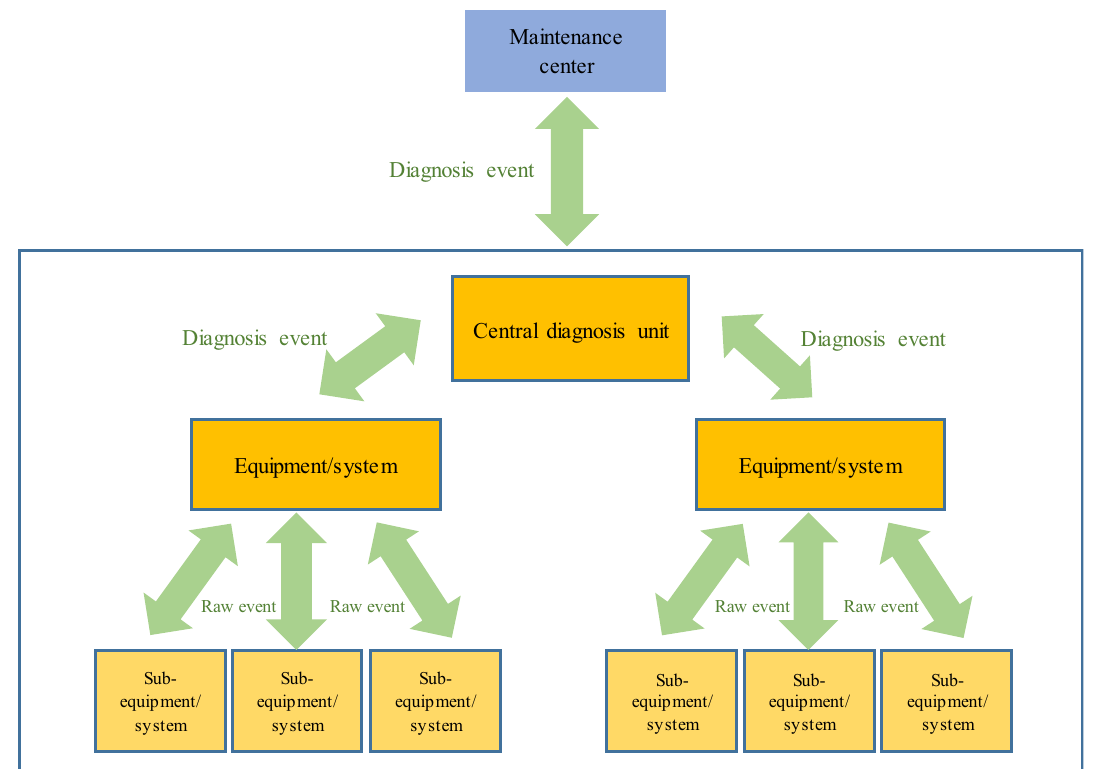
Fig. 4 Decentralized fleet